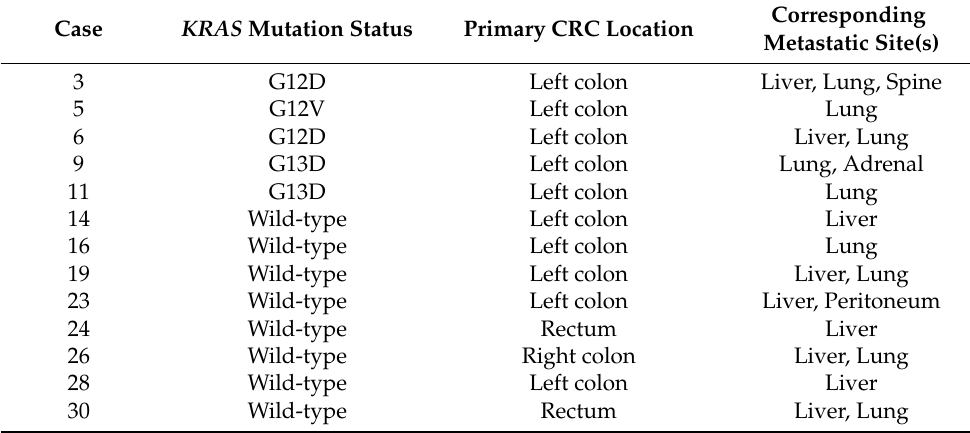
Table 3. Stage IV CRC with its corresponding metastatic site and KRAS mutation